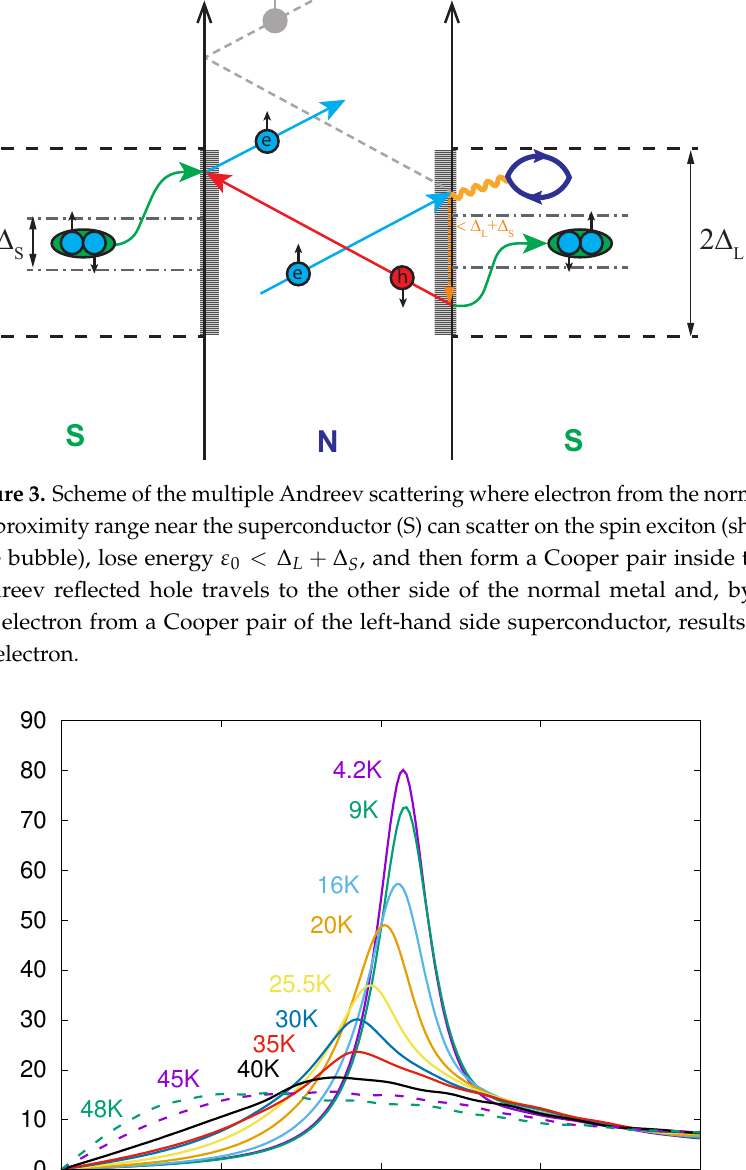
Figure 4. Positions of the maxima form the ω R ( T ) dependence that is plotted in Figure 2. Since, with the increasing temperature, the peaks become broader and their amplitudes diminish, the uncertainty in the spin exciton frequency increases.